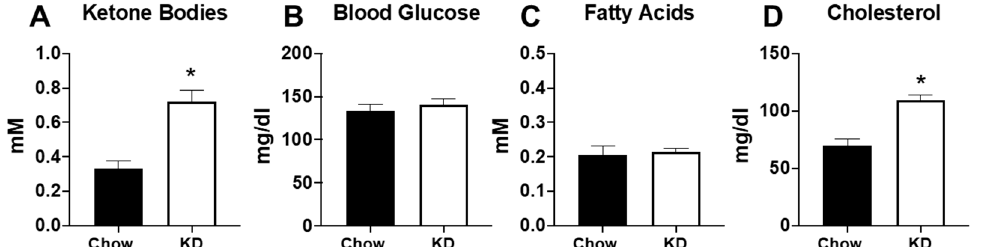
Figure 4. Five weeks of the ketogenic diet increased serum ketone bodies and cholesterol. ( A ) Serum ketone bodies; ( B ) serum glucose; ( C ) serum fatty acids, and ( D ) total cholesterol measured in chow-fed ( n = 6) and ketogenic diet (KD, n = 9) mice. * p < 0.05 vs. chow.